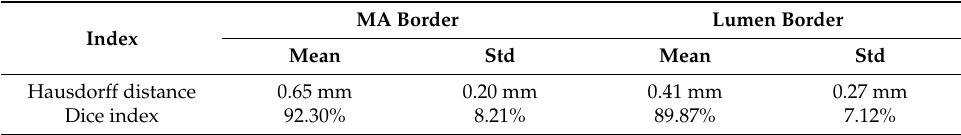
Table 1. Mean and standard deviations (Std) of the Dice similarity and Hausdorff distance between the lumen/MA (media-adventitia) border obtained by our method and manual delineation.